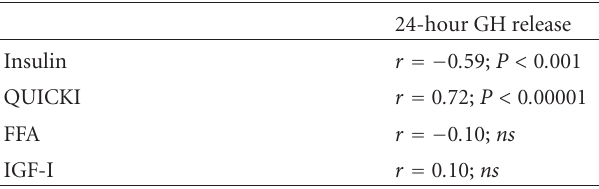
Table 2: Correlations between 24-hour GH release, IGF-I, FFA insulin, and insulin sensitivity in all subjects (non-obese, obese, and previously obese